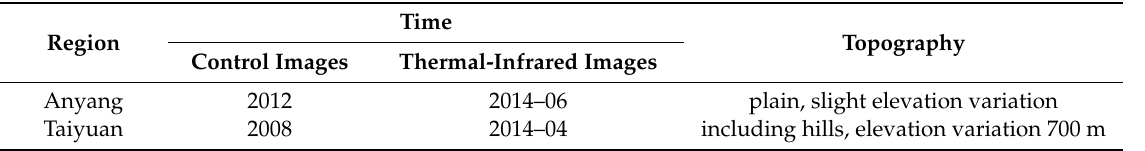
Table 1. Experimental data sets.